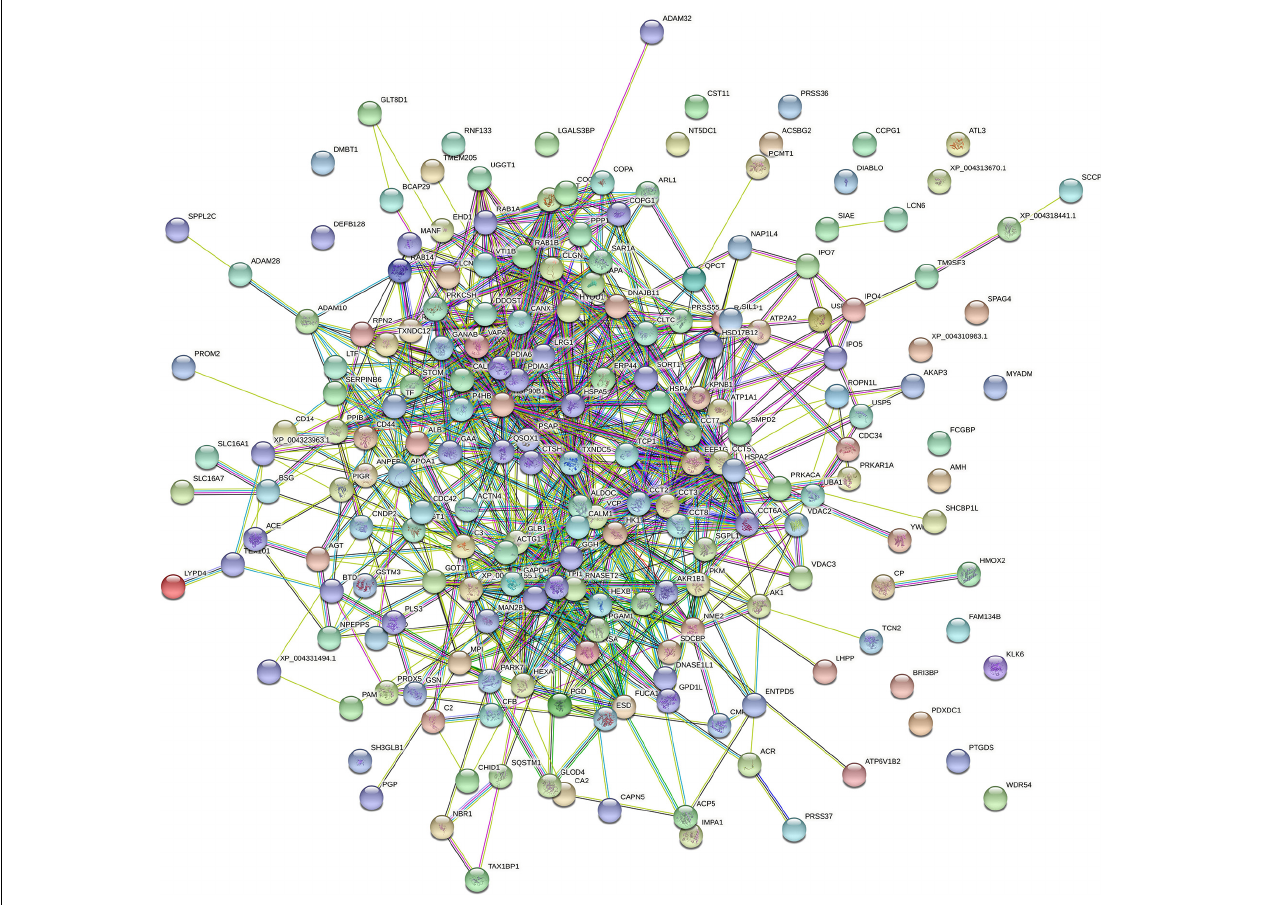
FIGURE 6 | STRING protein–protein interaction network showing the interactions of the seminal plasma proteins identified in bottlenose dolphin.